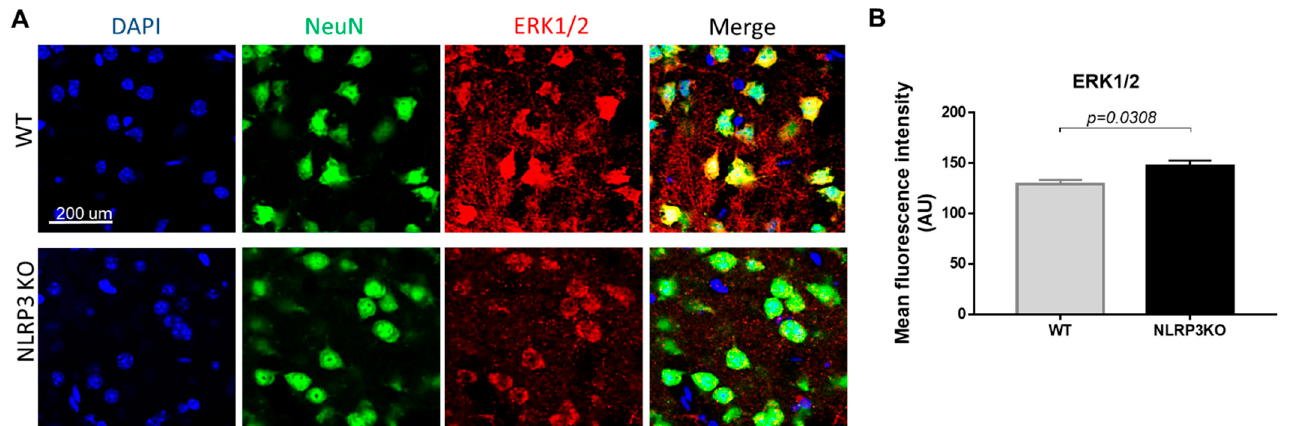
Figure 10. Expression of ERK1/2 in mature neurons of the basolateral amygdala in mice. ( A ) Triple immunofluorescent staining: cell nuclei—DAPI (blue), NeuN (green), ERK1/2 (red), signal overlay (Merge). Scale Bar—200 μ m. ( B ) Mean fluorescence intensity of ERK1/2/NeuN + cells in arbitrary units. WT—control mice group, NLRP3KO—NLRP3 knockout mice. Data are presented as a mean ± SEM.